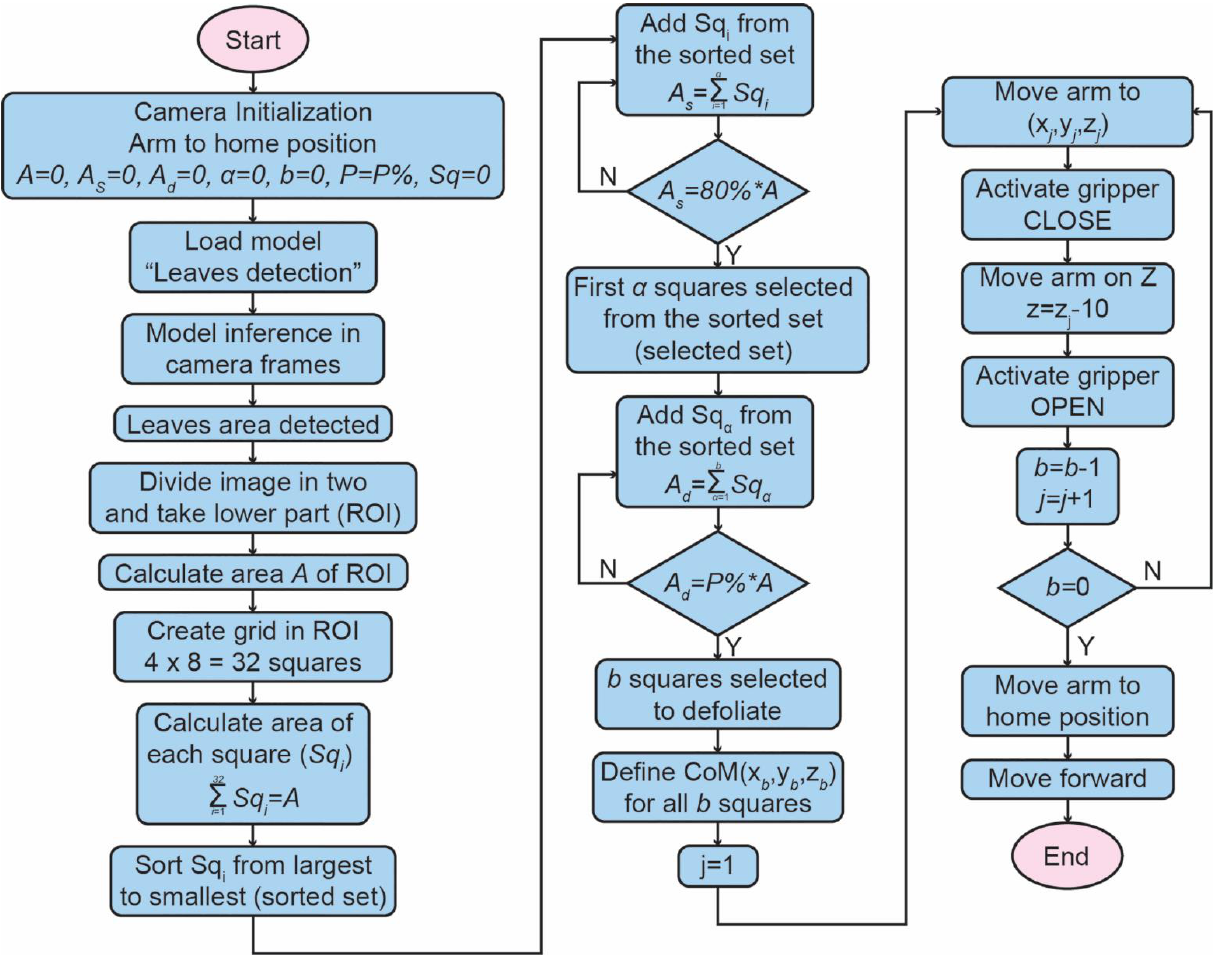
Figure 5. Workflow of the defoliation task.